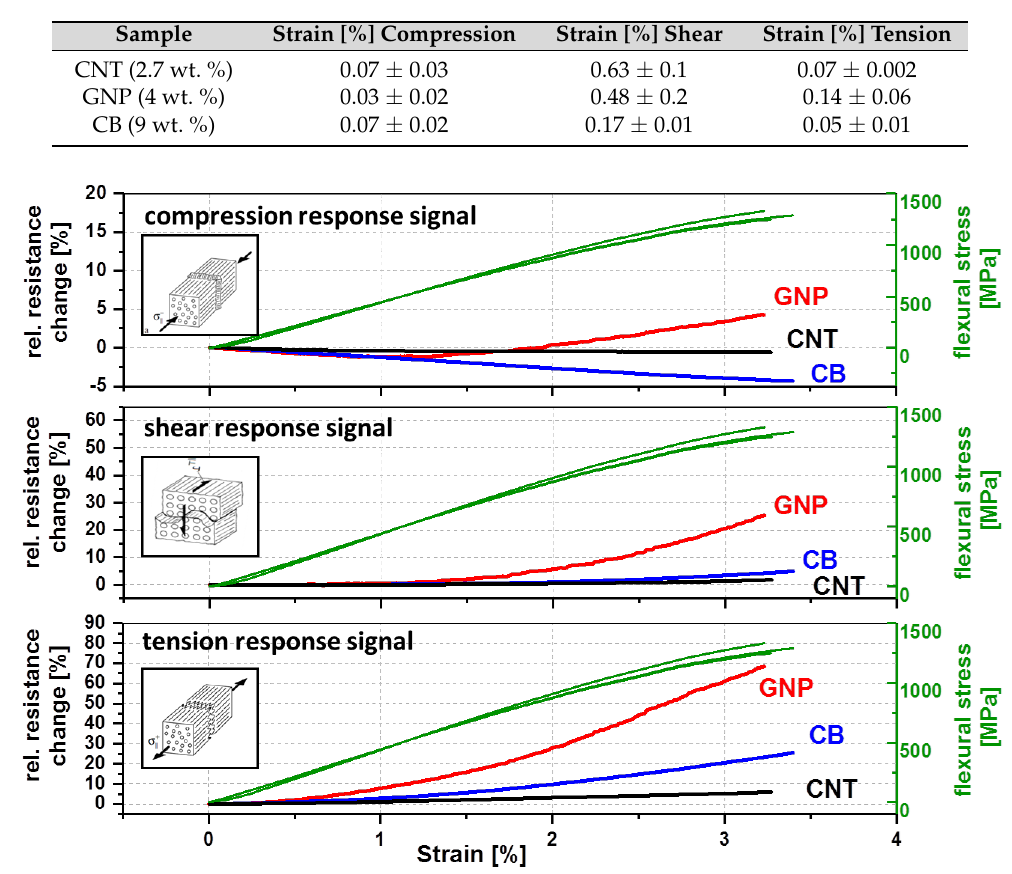
Figure 8. Electro-mechanical response behavior of nanostructured sensor fiber using different carbon filler (CNT, GNP, CB) embed in the planes of maximum stresses for compression, shear and tension, during a quasi-static three-point bending (Span to Length L/h ratio of